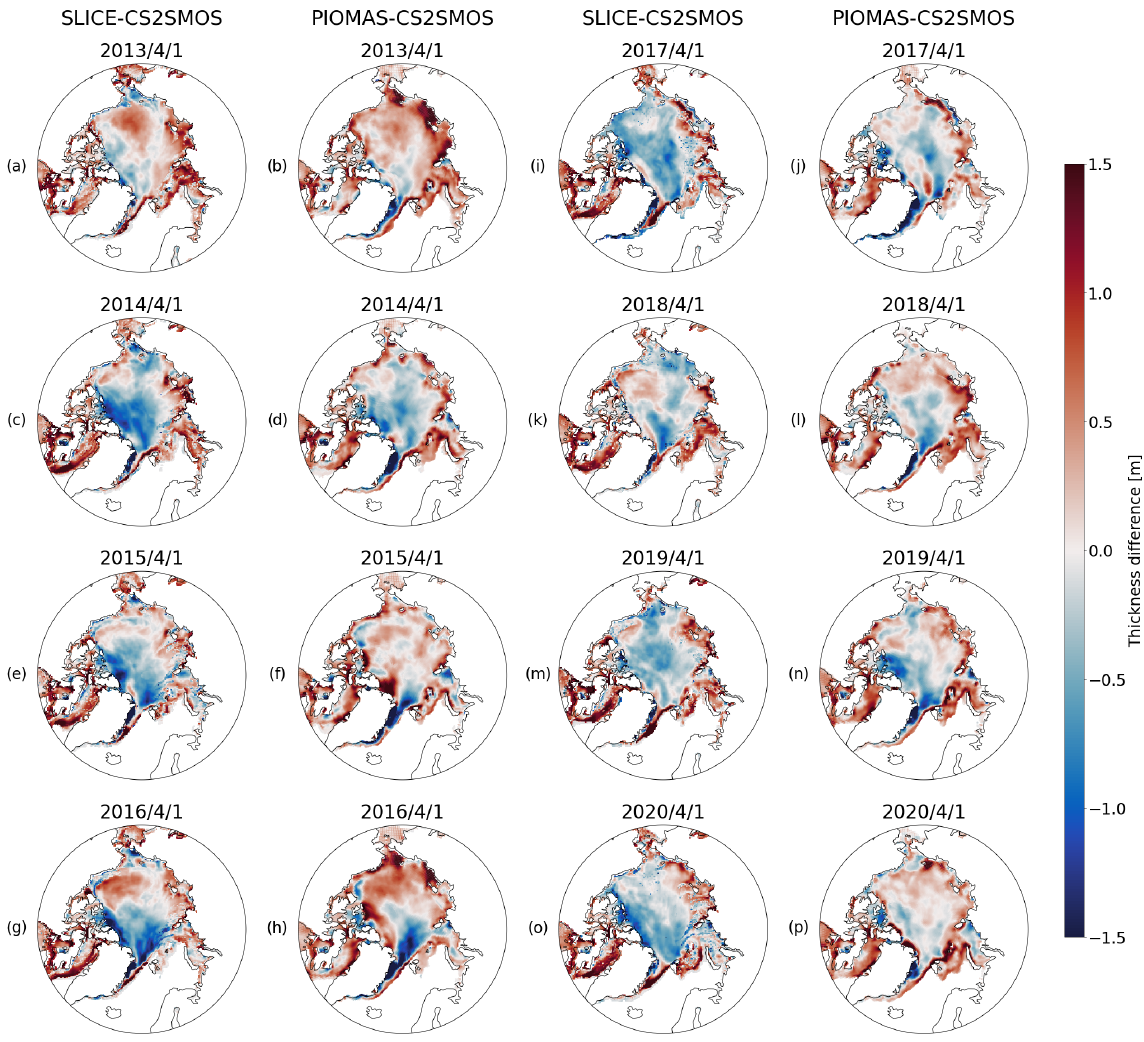
Figure 7. For the sea ice growth seasons ending in (a, b) 2013, (c, d) 2014, (e, f) 2015, (g, h) 2016, (i, j) 2017, (k, l) 2018, (m, n) 2019, and (o, p) 2020, (a, c, e, g, i, k, m, o) SLICE sea ice thickness minus AWI CS2SMOS sea ice thickness from 1 April and (b, d, f, h, j, l, n, p) PIOMAS sea ice thickness minus AWI CS2SMOS sea ice thickness from 1 April. The SLICE and PIOMAS differences show similarities in their overall